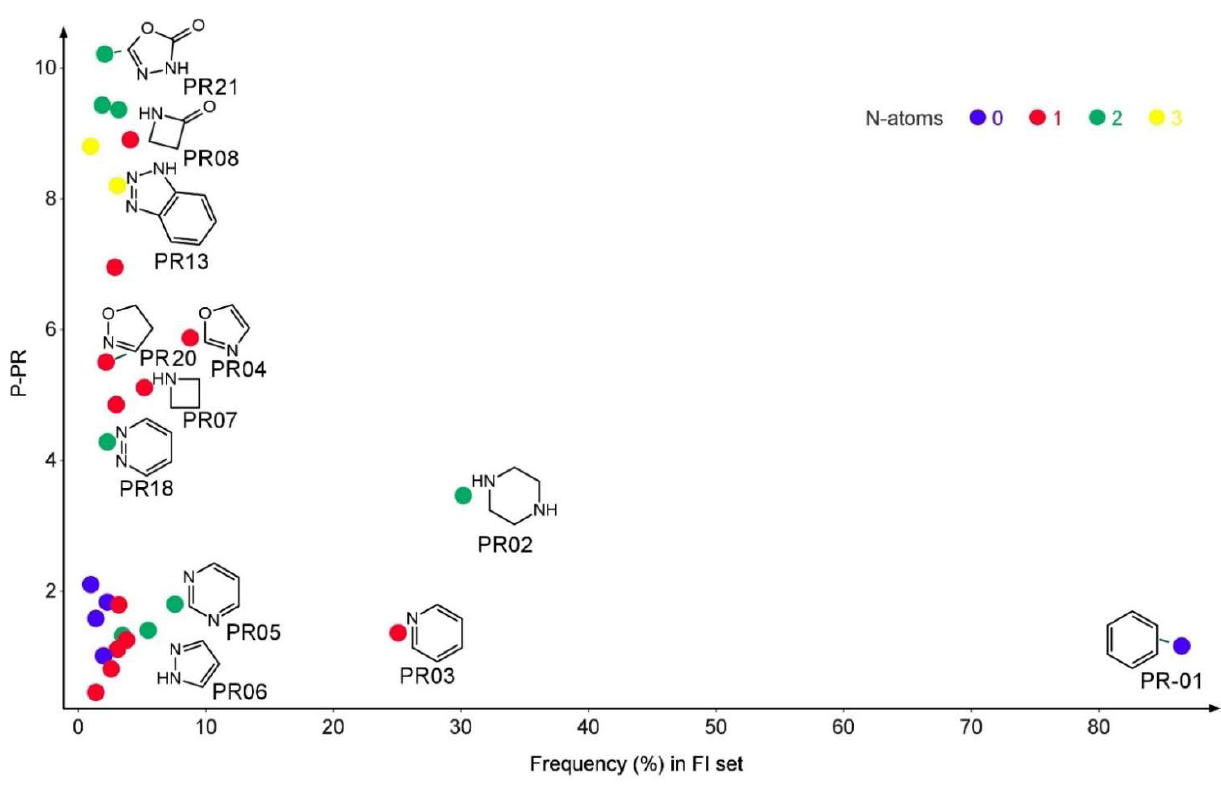
Table 2. List of molecular descriptors with significantly different values in relation to strong and weak FAAH inhibitors. The cutoff value indicates the threshold for discriminating strong FAAH inhibitors.